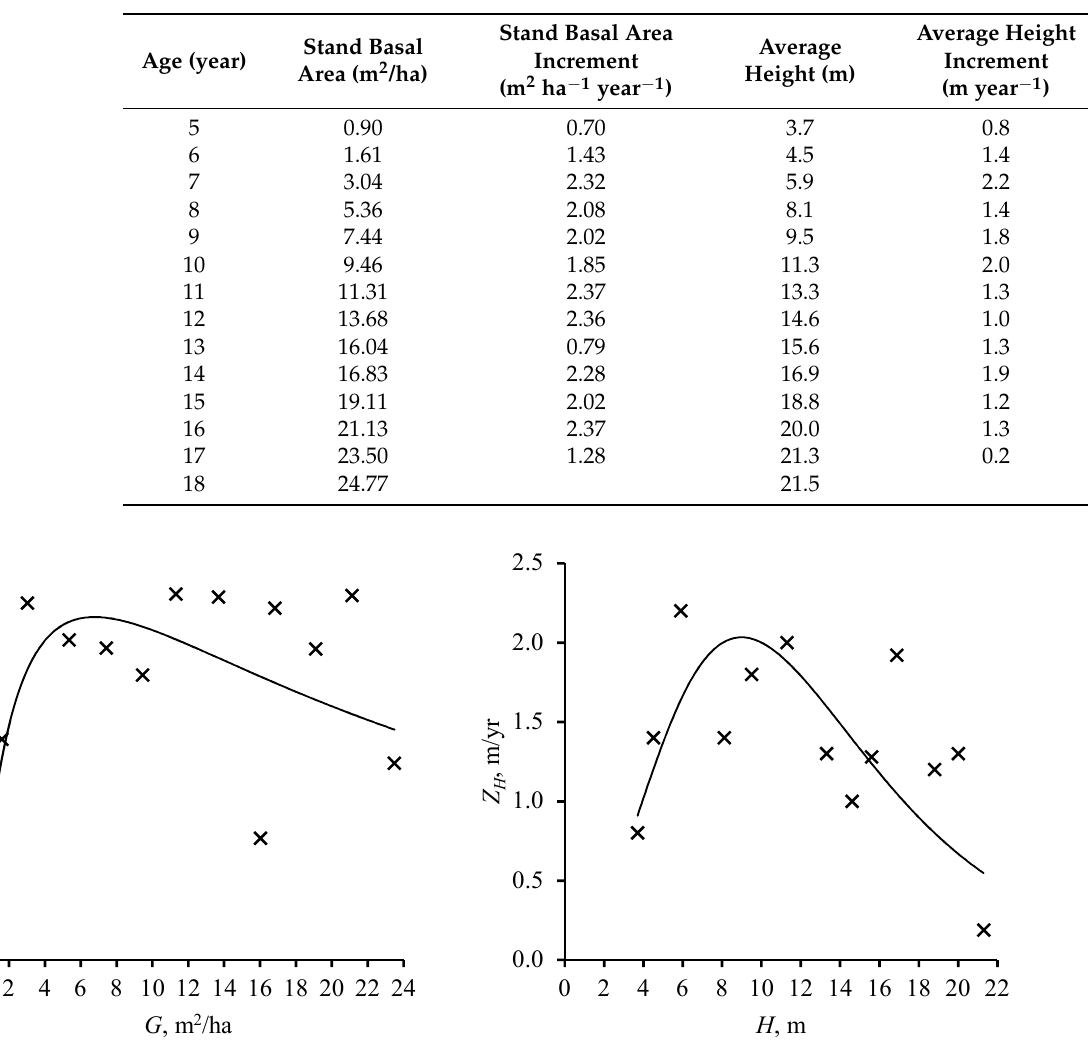
Table 1. First-rotation (planted) hybrid aspen stand growth data.